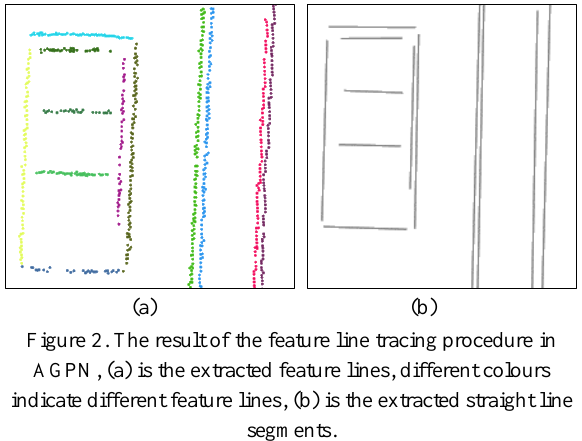
Figure 2. The result of the feature line tracing procedure in AGPN, (a) is the extracted feature lines, different colours indicate different feature lines, (b) is the extracted straight line segments.